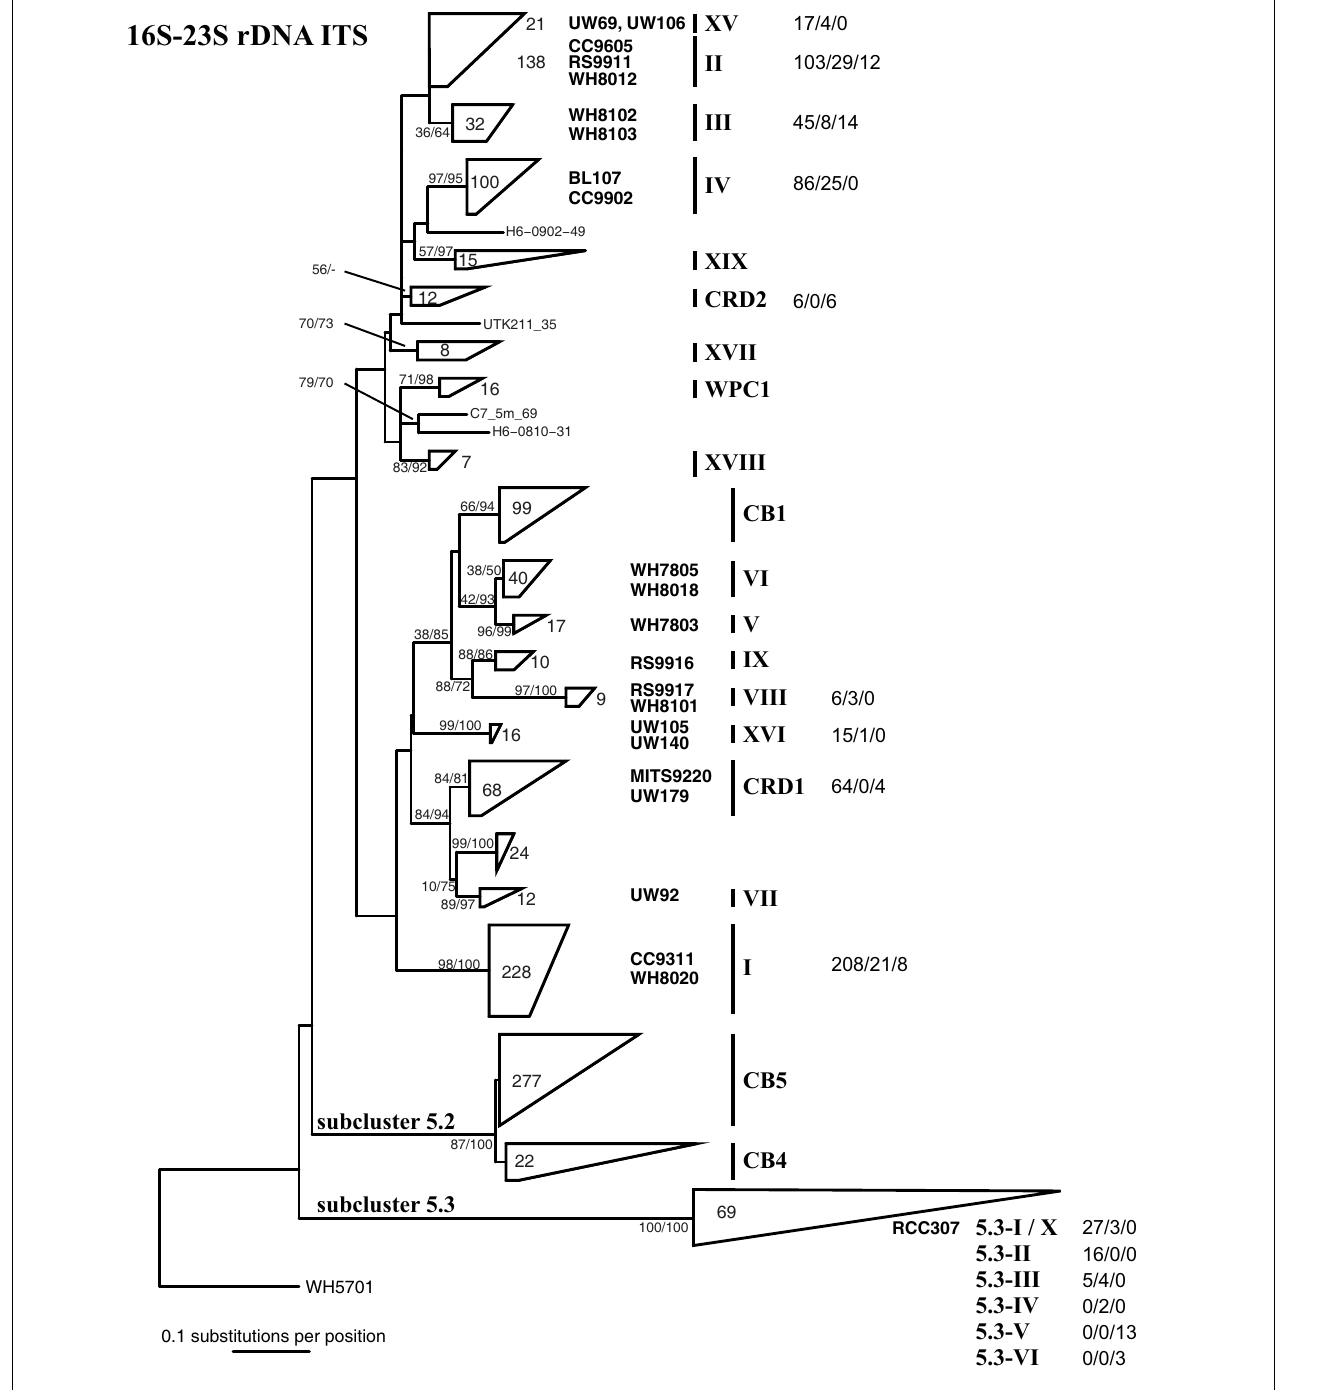
trapezoids.The number inside or to the right of the trapezoid indicates the number of sequences in that clade or subcluster. Clade designations are indicated with solid vertical lines, and representative strains within the clades are shown to the left of clade labels. Clade XV forms a monophyletic clade highly supported by bootstrap analysis (80/86, not shown on tree) and groups together with clade II strains. For clades for which qPCR assays were designed, numbers to the right of clade names show the number of sequences that have zero, one to two, or greater than two mismatches to both the forward and reverse qPCR primers combined (0 mismatches/1–2 mismatches/ > 2